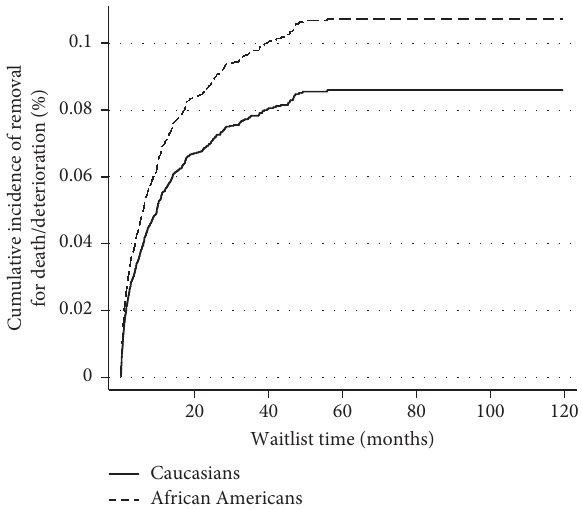
Figure 1: Competing risk analysis for cumulative incidence of death or waitlist removal for clinical deterioration with transplant as competing